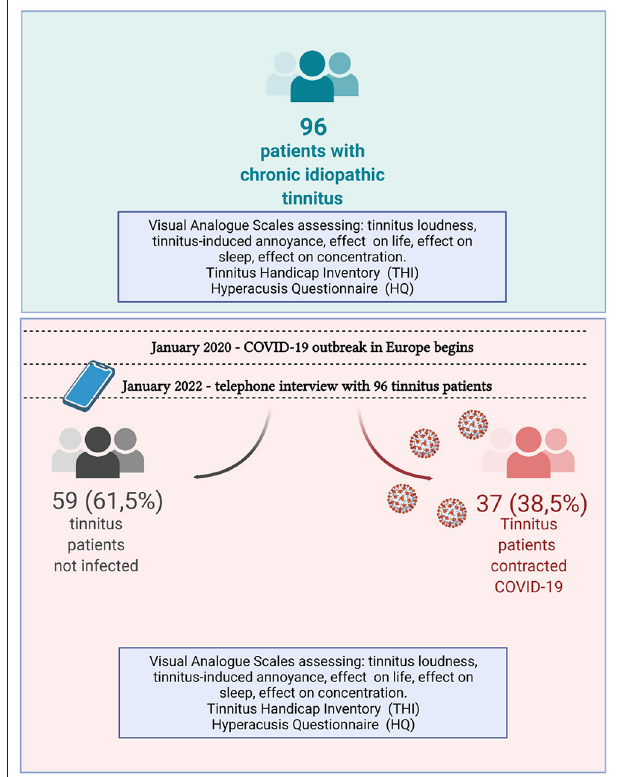
FIGURE 2 | Schematic drawing showing the study design and a